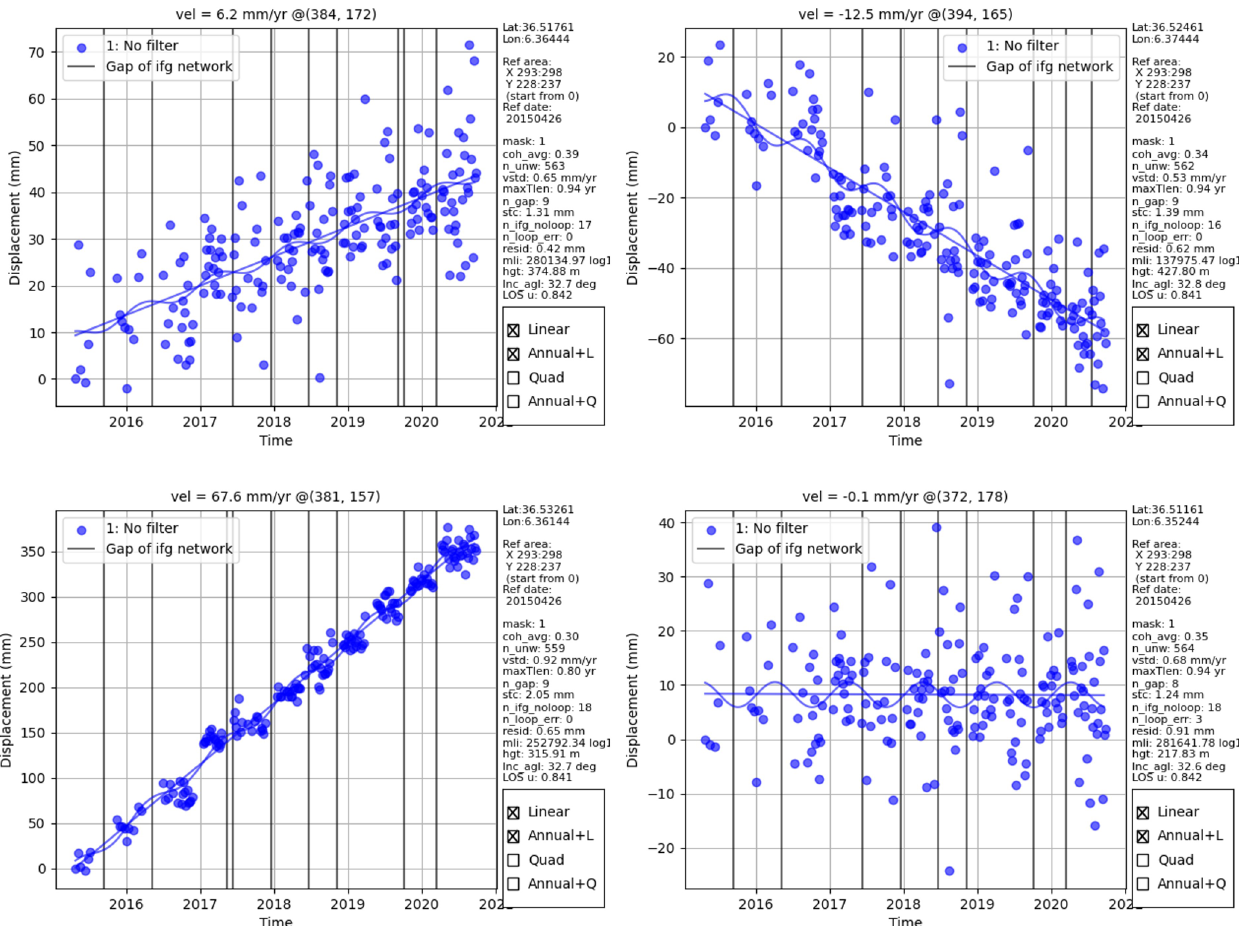
Figure 19. Displacement time series (orbit 161), corresponding to the points in Fig. 17b, The plots show less dispersion of data points (linear) compared to short analysis. The long-period analysis (5 years) is useful to eliminate other sources of